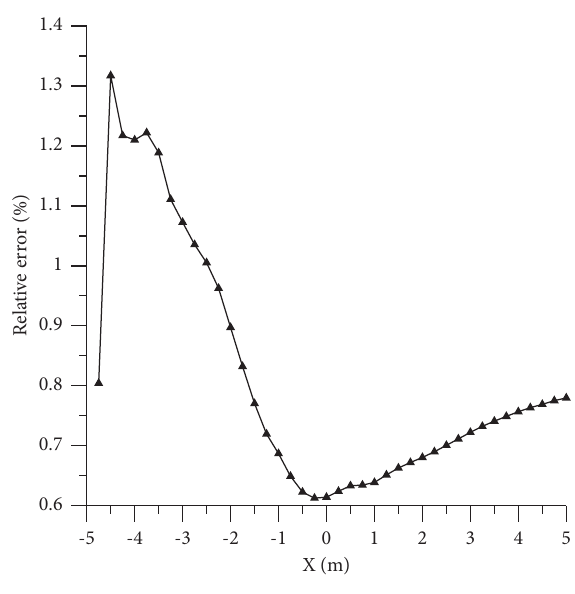
Figure 4: Relative